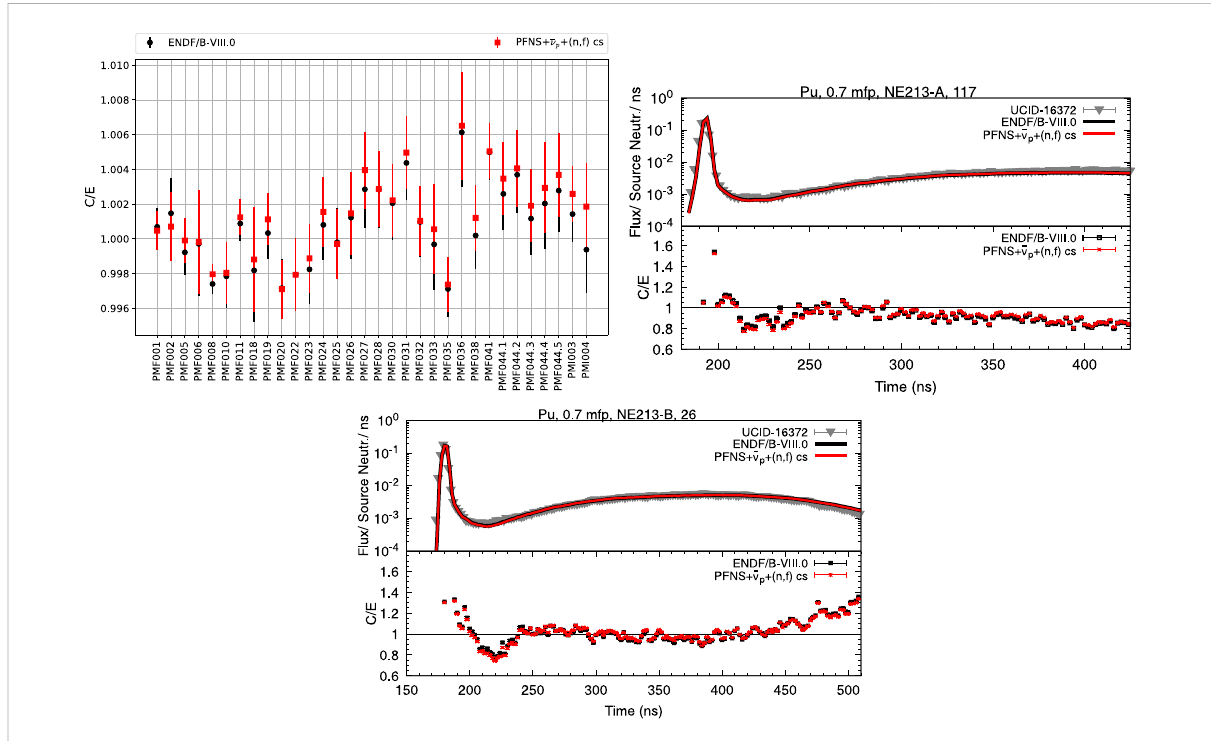
FIGURE 10 Simulated values ( “ C ” ) for k eff of PMF and PMI assemblies (left) and two Pu LLNL pulsed sphere neutron leakage spectra (other two plots) are depicted for ENDF/B-VIII.0 versus the new fi ssion source term. Experimental data ( “ E ” ) are shown for comparison.